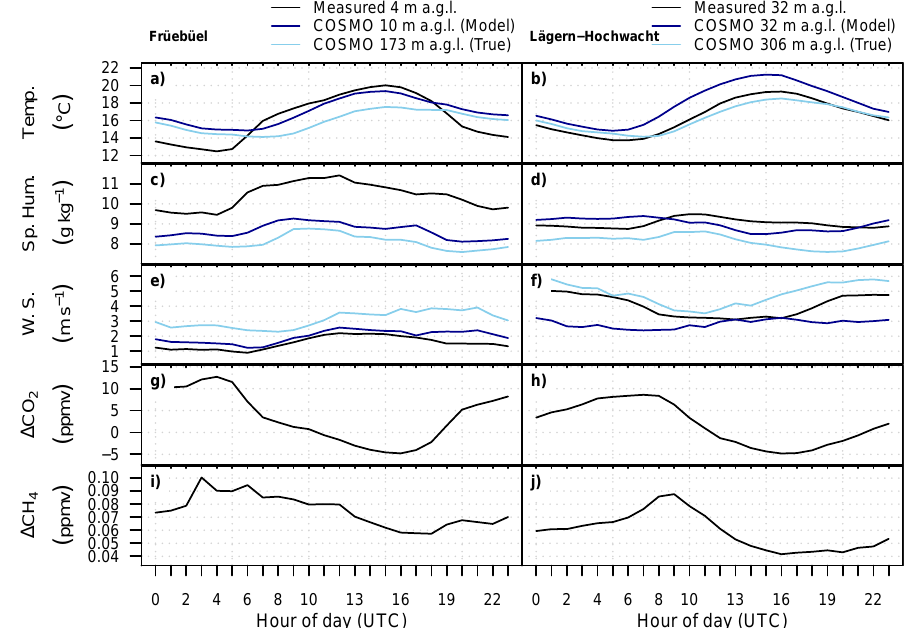
Figure 7. Similar to Fig. 5, the mean diurnal cycles during summer (June–August 2013) at the sites Früebüel and Lägern-Hochwacht. The Früebüel meteorological measurements were made at 2ma . g .